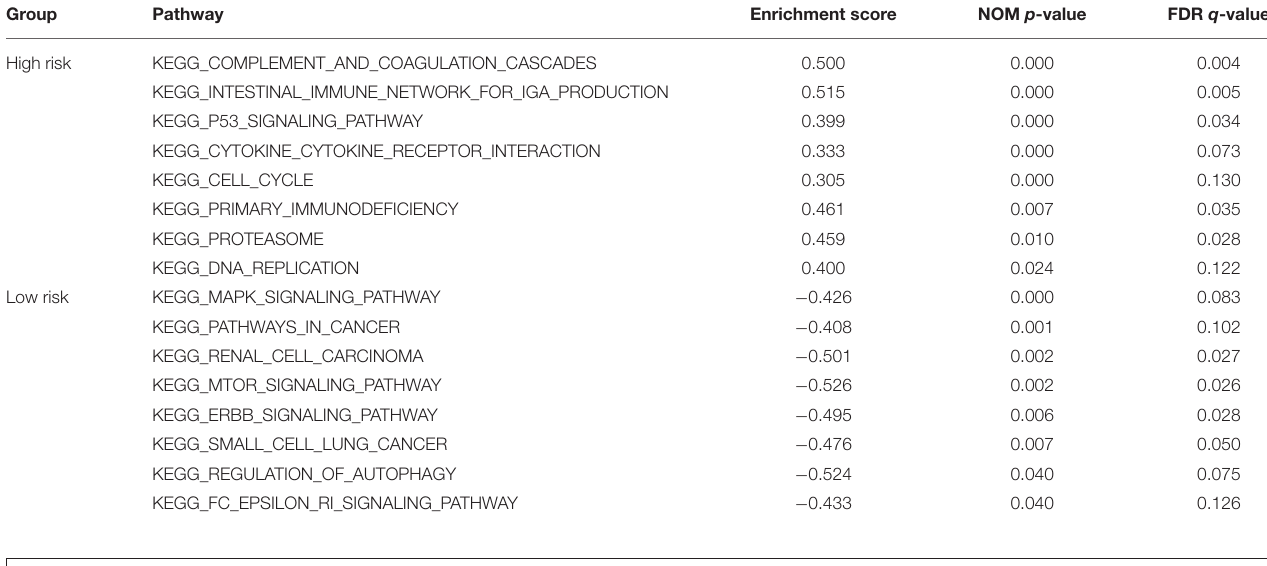
TABLE 4 | GSEA based on the 3-lncRNA prognostic signature. Group